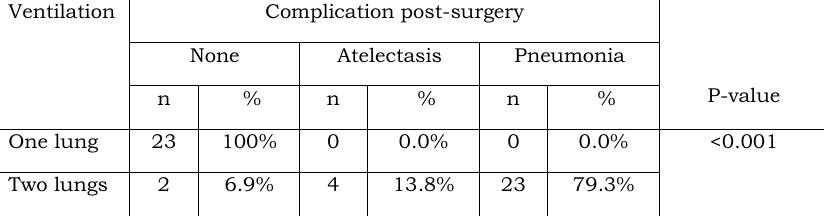
Table 3: Relationship between ventilation and surgical complications